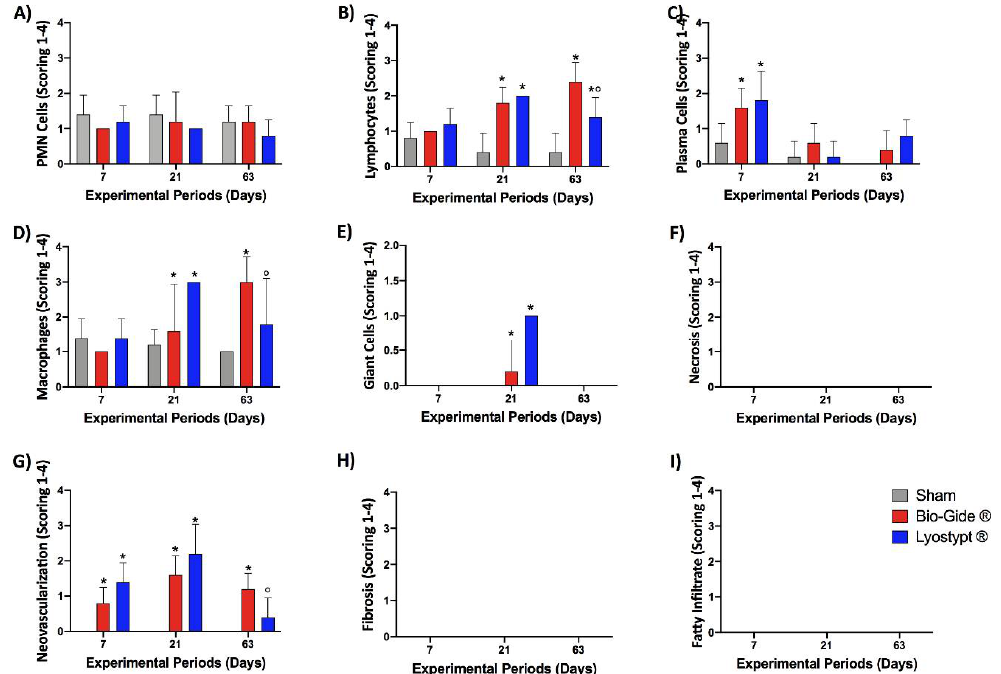
Figure 5. Inflammatory cells’ response ( A – F ) and overall tissue reaction ( G – I ) of Sham, Bio-Gide ® , and Lyostypt ® groups after 7, 21, and 63 days of implantation. Data +/- standard deviation; p < 0.05; (*) represents a significant difference when compared to the Sham group; (°) represents significantly greater when compared to the Bio-Gide ® group.